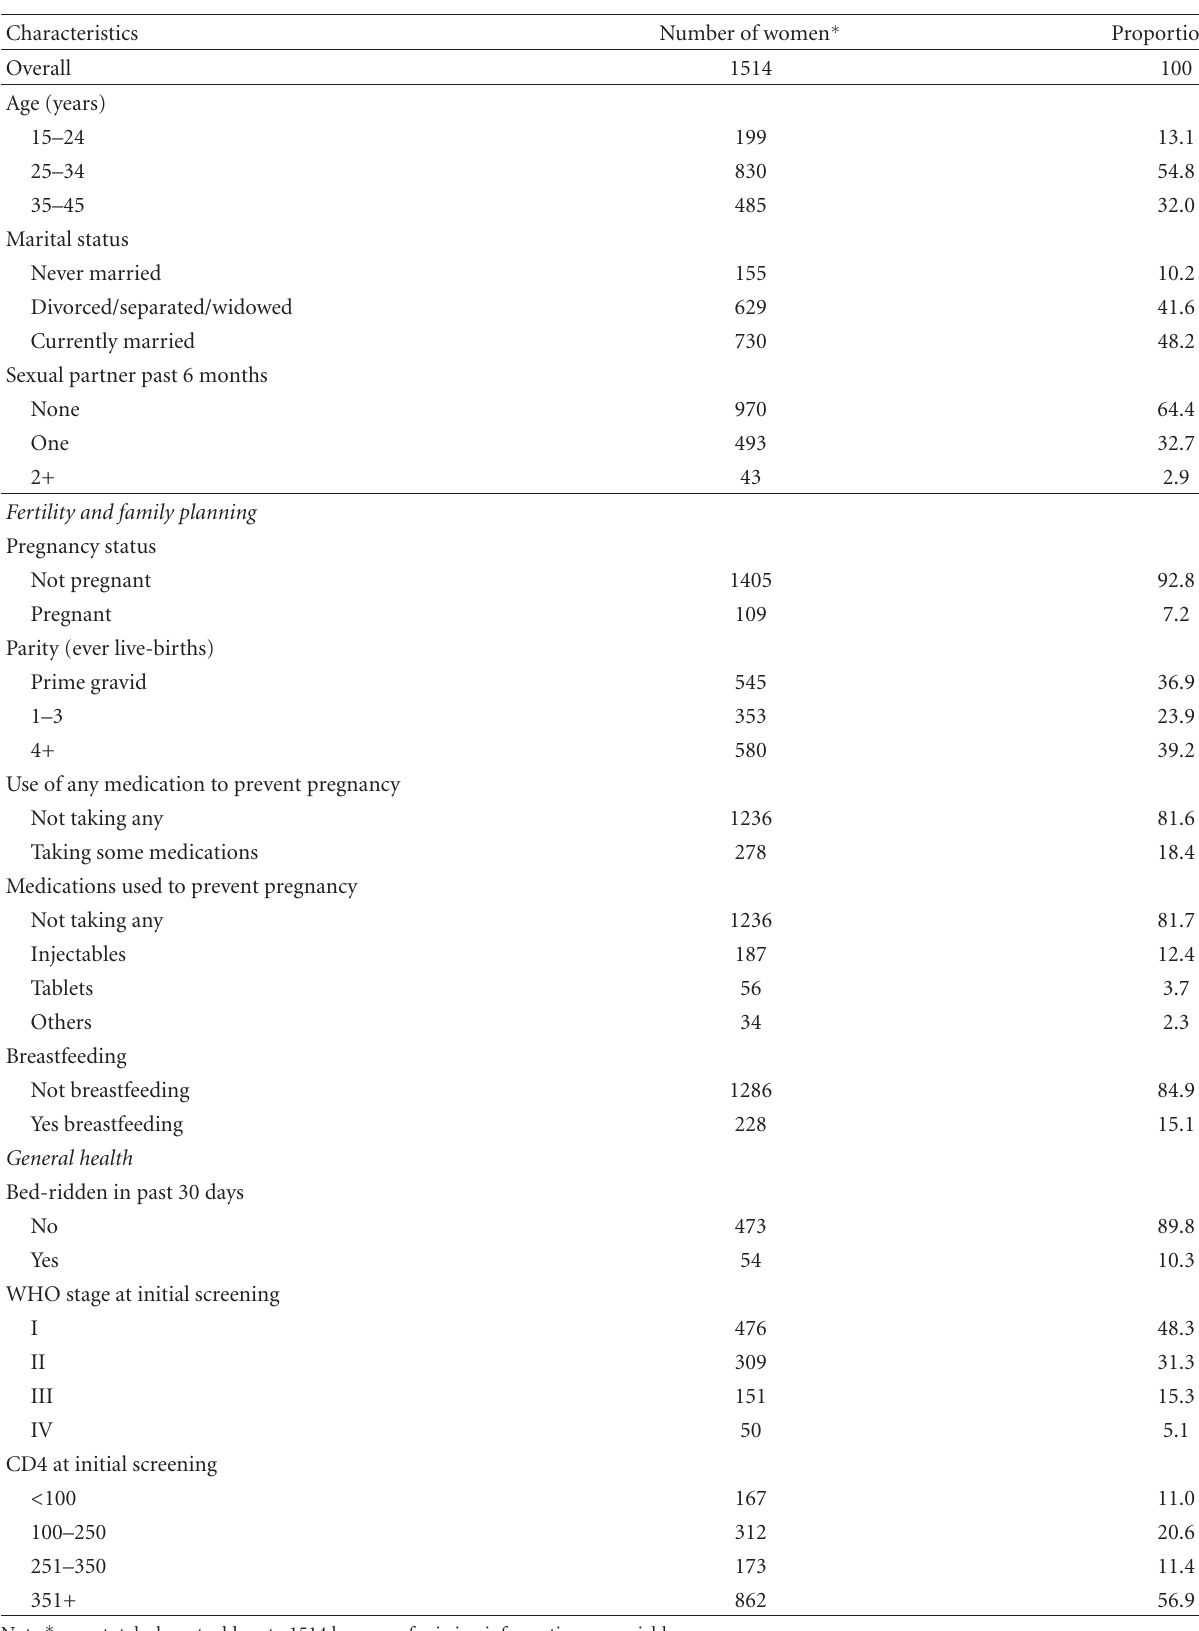
Table 1: Characteristics of women enrolling into pre-ART HIV